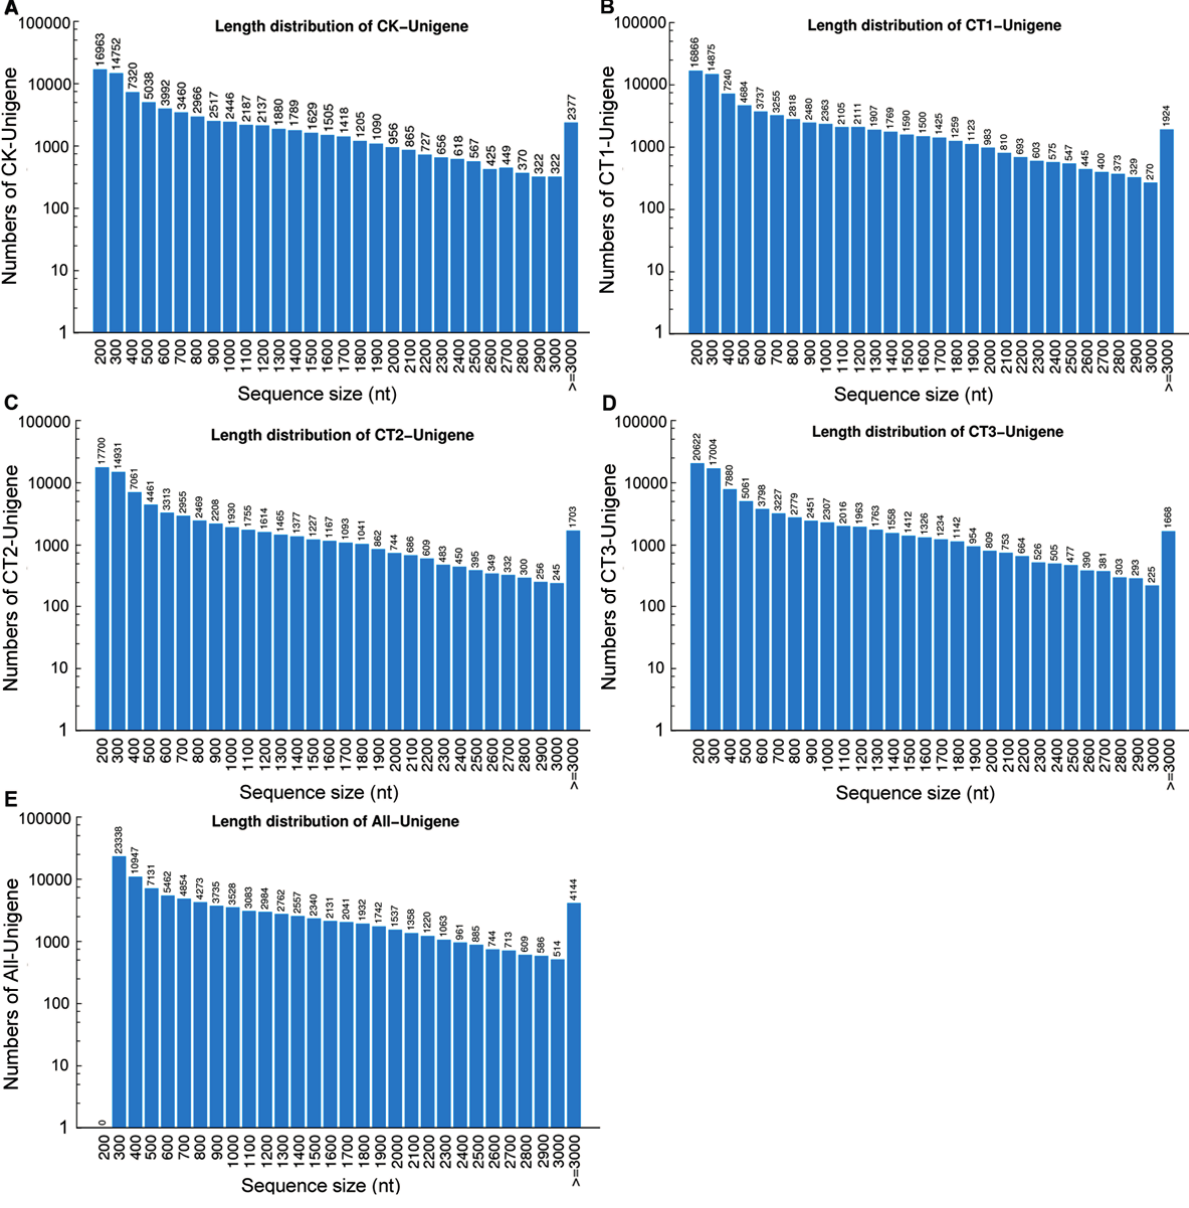
Figure 2. Length distributions of the unigenes from cold-treated (CT) and control (CK) samples. ( A − E ) The length distributions of unigenes from CK ( A ); CT1 ( B ); CT2 ( C ); CT3 ( D ); and all samples ( E